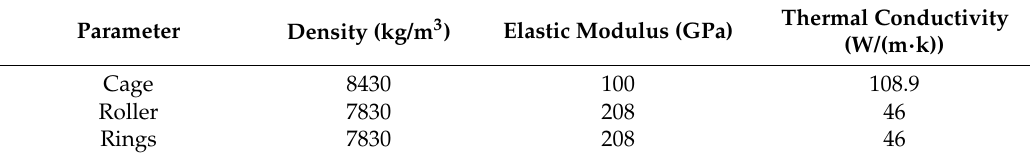
Table 2. Material parameters of the roller bearing.